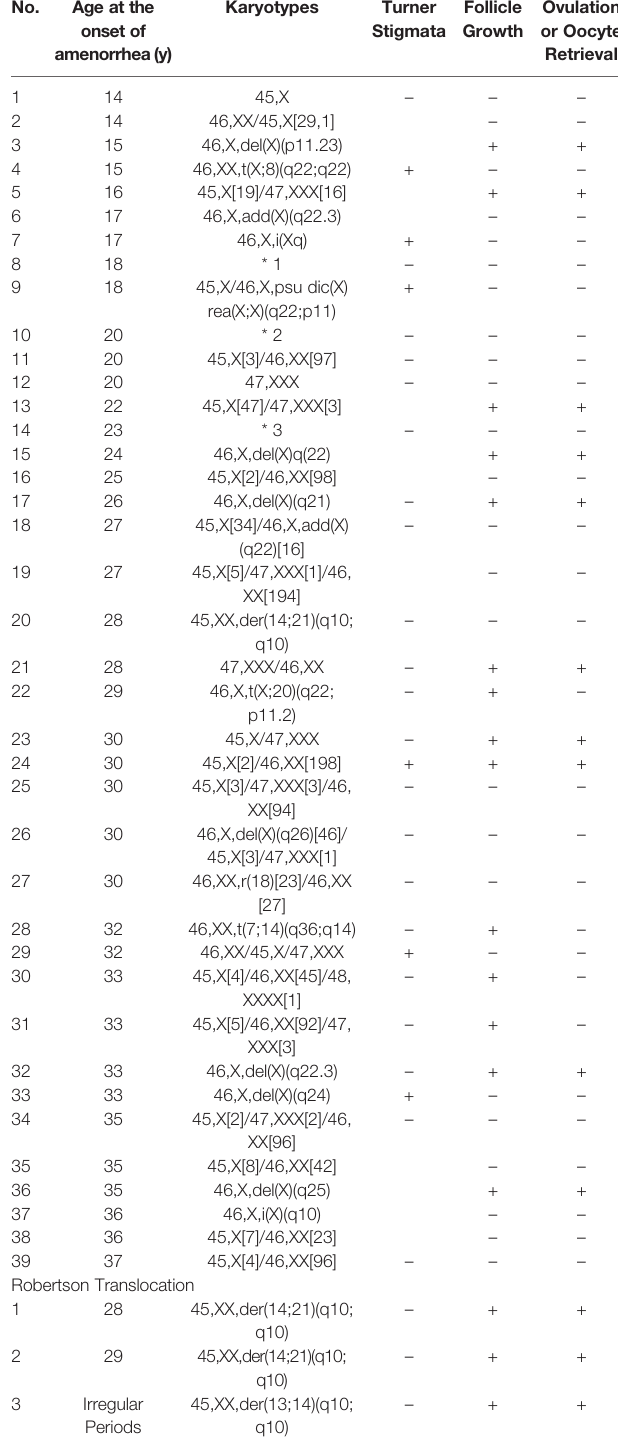
TABLE 2 | Karyotypes and ages at onset of amenorrhea in 42 representative POI cases with chromosomal abnormalities